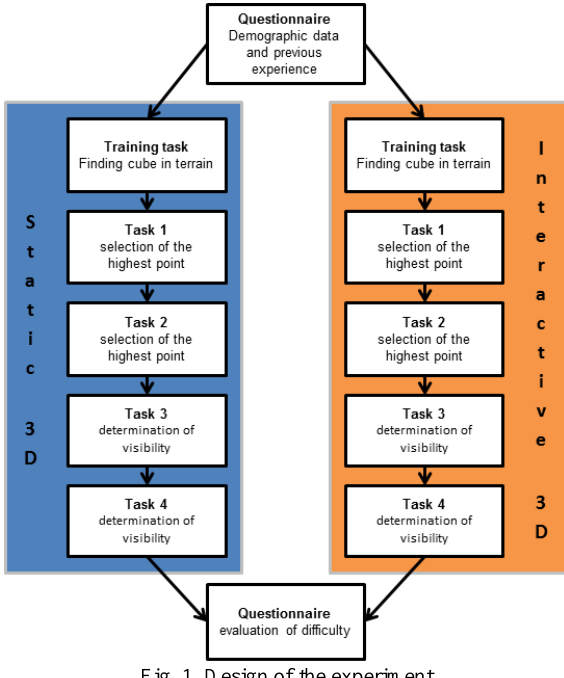
Fig. 1. Design of the experiment